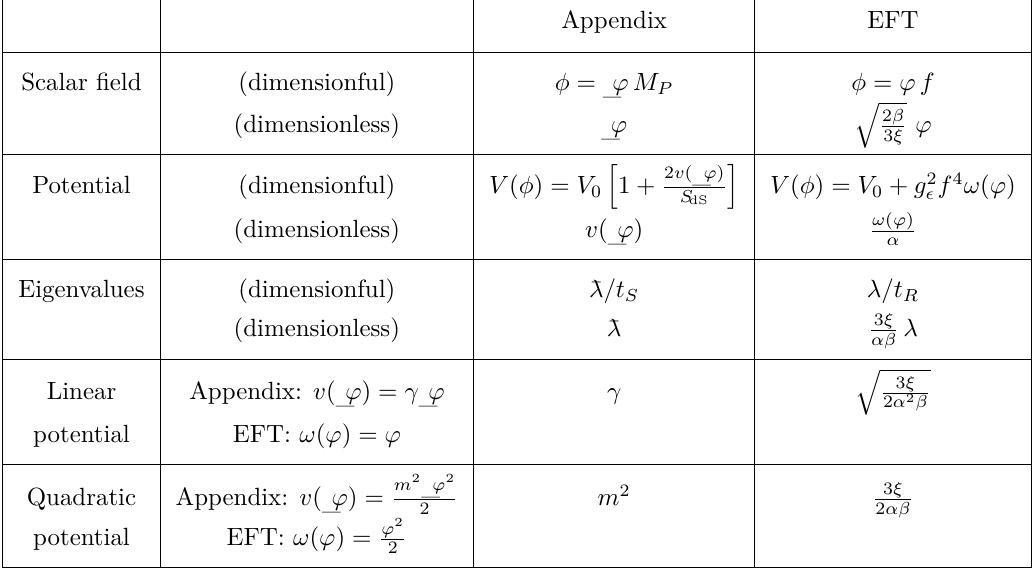
Table 1 . The conversion between the notations used in this appendix and those of the EFT approach. Quantities in the same line of the table are equal, but expressed in the corresponding